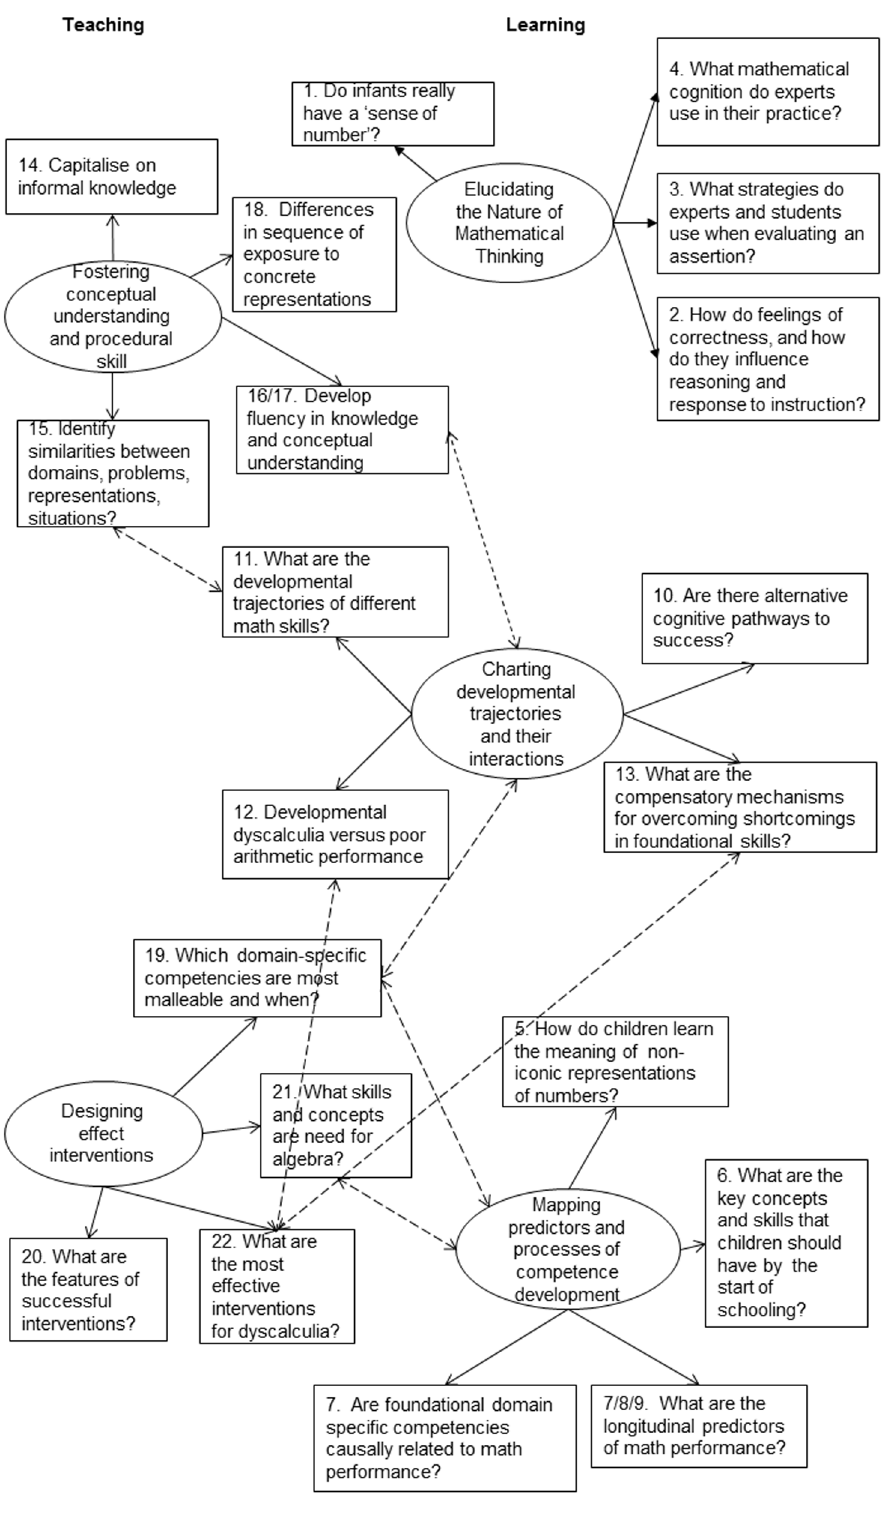
Figure 1. Domain areas and questions identified in “Challenges in mathematical cognition: A collaboratively-derived research agenda”. Dotted lines denote potential interconnections between questions and domain